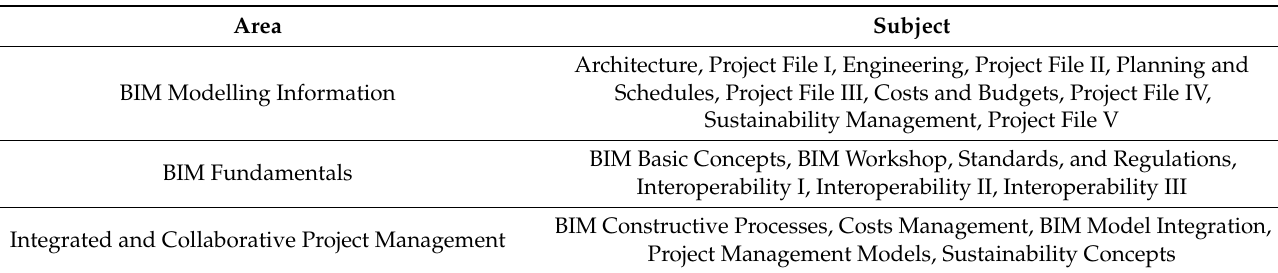
Table 5. BIM training areas and subjects.